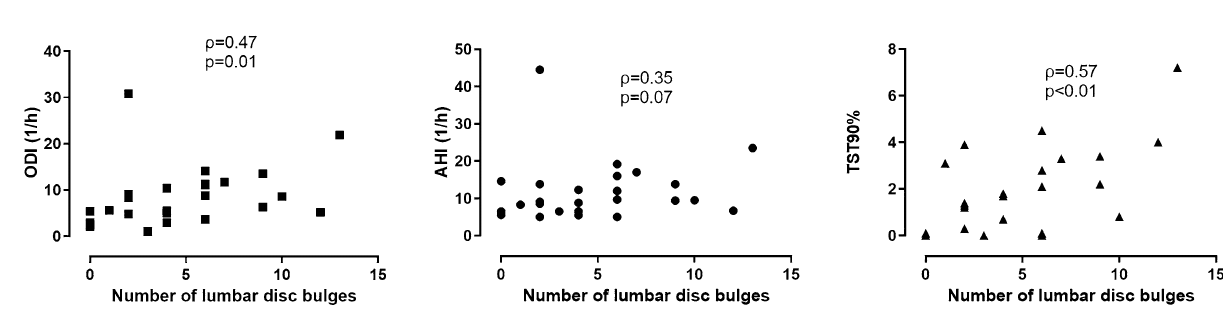
Figure 1. The relationship between the number of lumbar disc bulges and markers of OSA